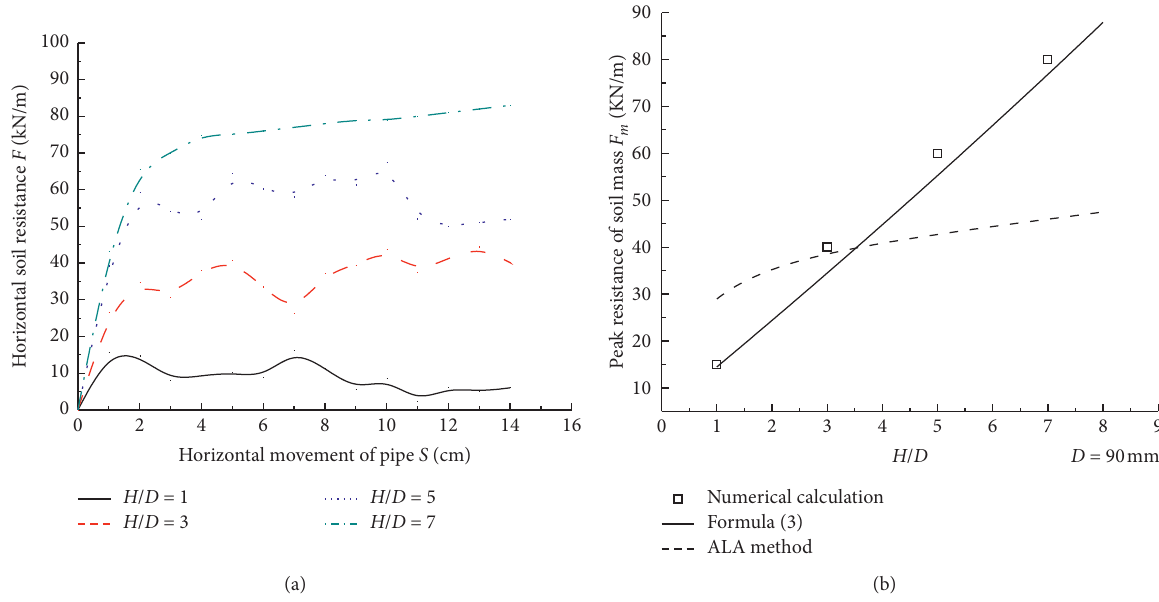
Figure 16: The comparison of formula (3) to the ALA method. (a) Soil resistance displacement curve calculated by the numerical method. (b) The peak resistance obtained by formula (3), ALA method, and numerical calculation.